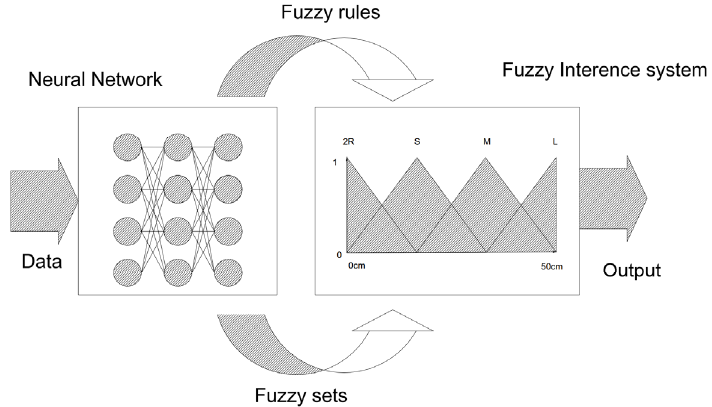
Figure 5. The block diagram describes the operation of the Neural-Fuzzy operating system.